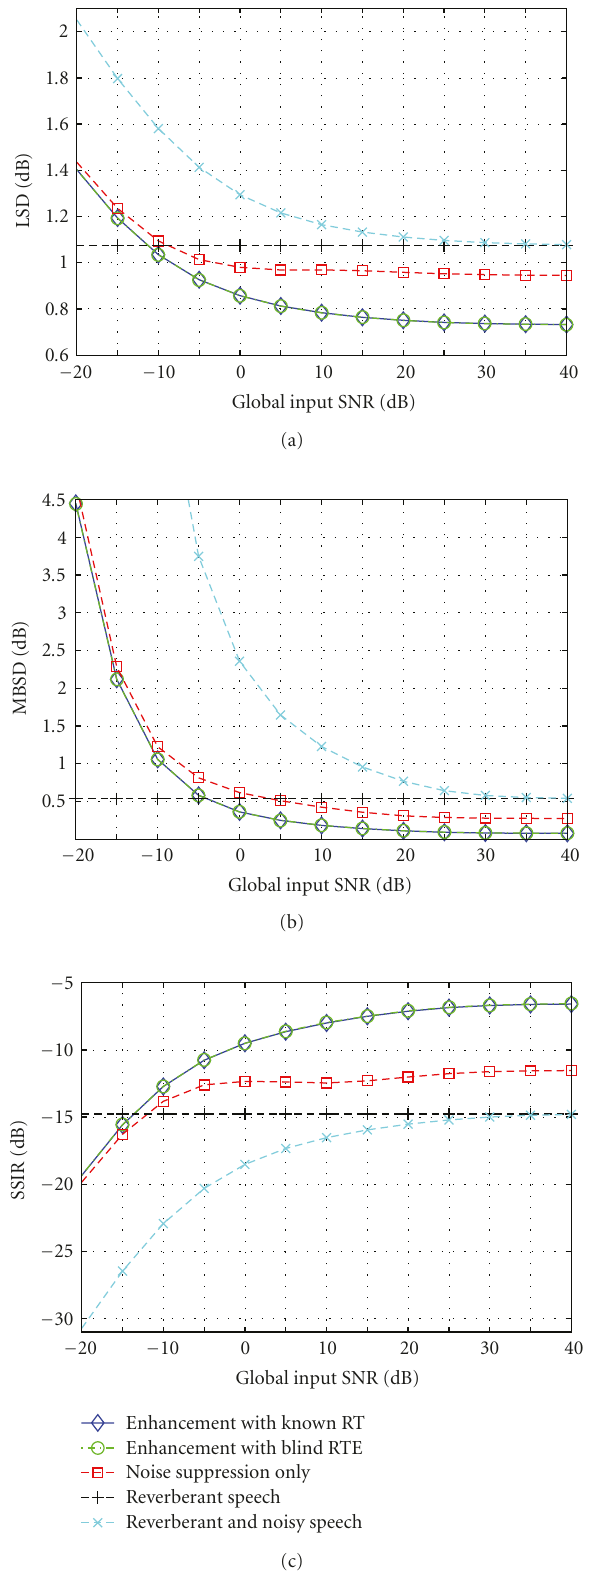
Figure 4: Log-spectral distance (LSD), modified Bark spectral dis- tortion (MBSD) and segmental signal-to-interference ratio (SSIR) for varying global input SNRs and di ff erent